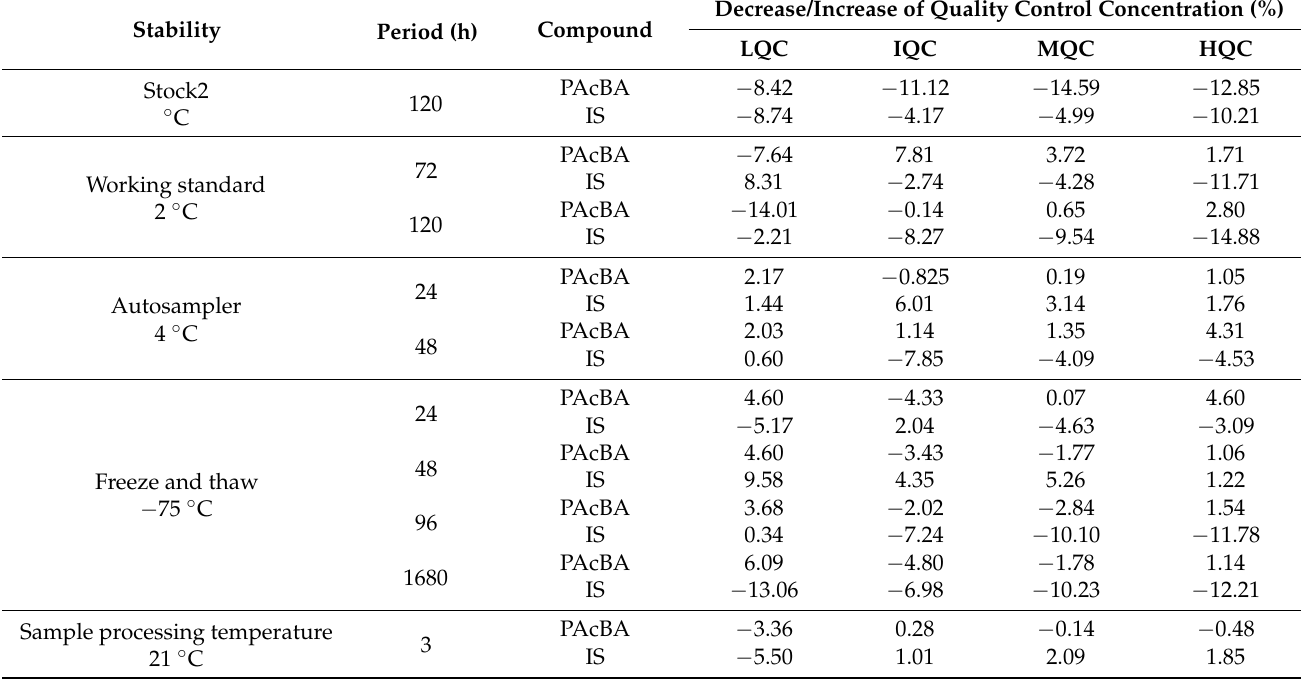
Table 4. Stability tests